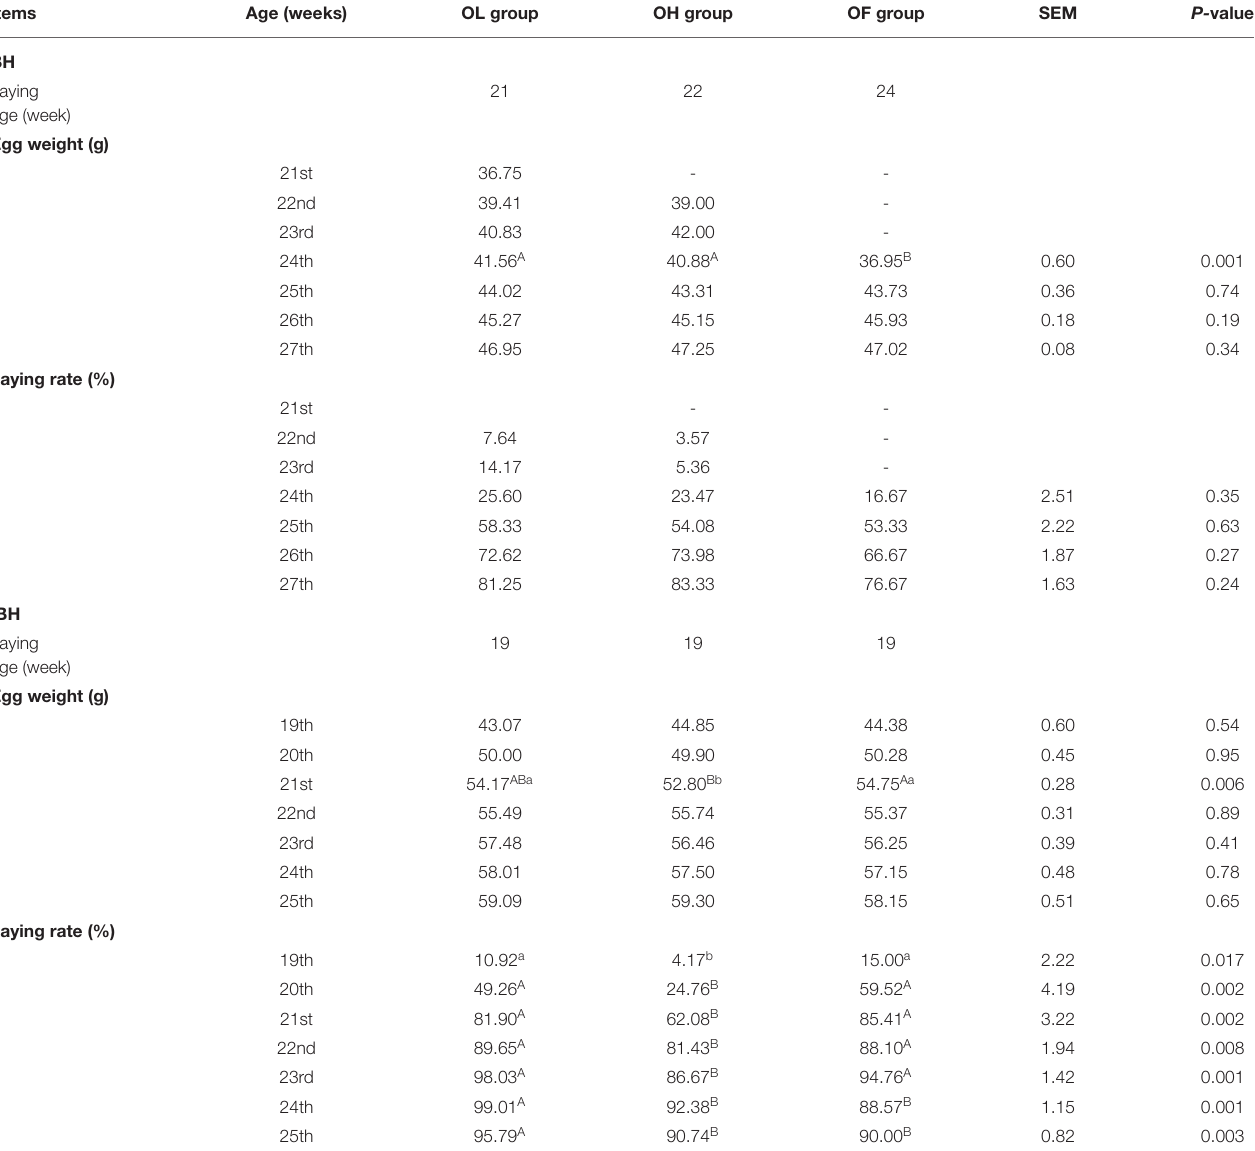
TABLE 2 | Effect of adding eubiotic lignocellulose on the laying performance of BH and IBH. Items OL group OF group